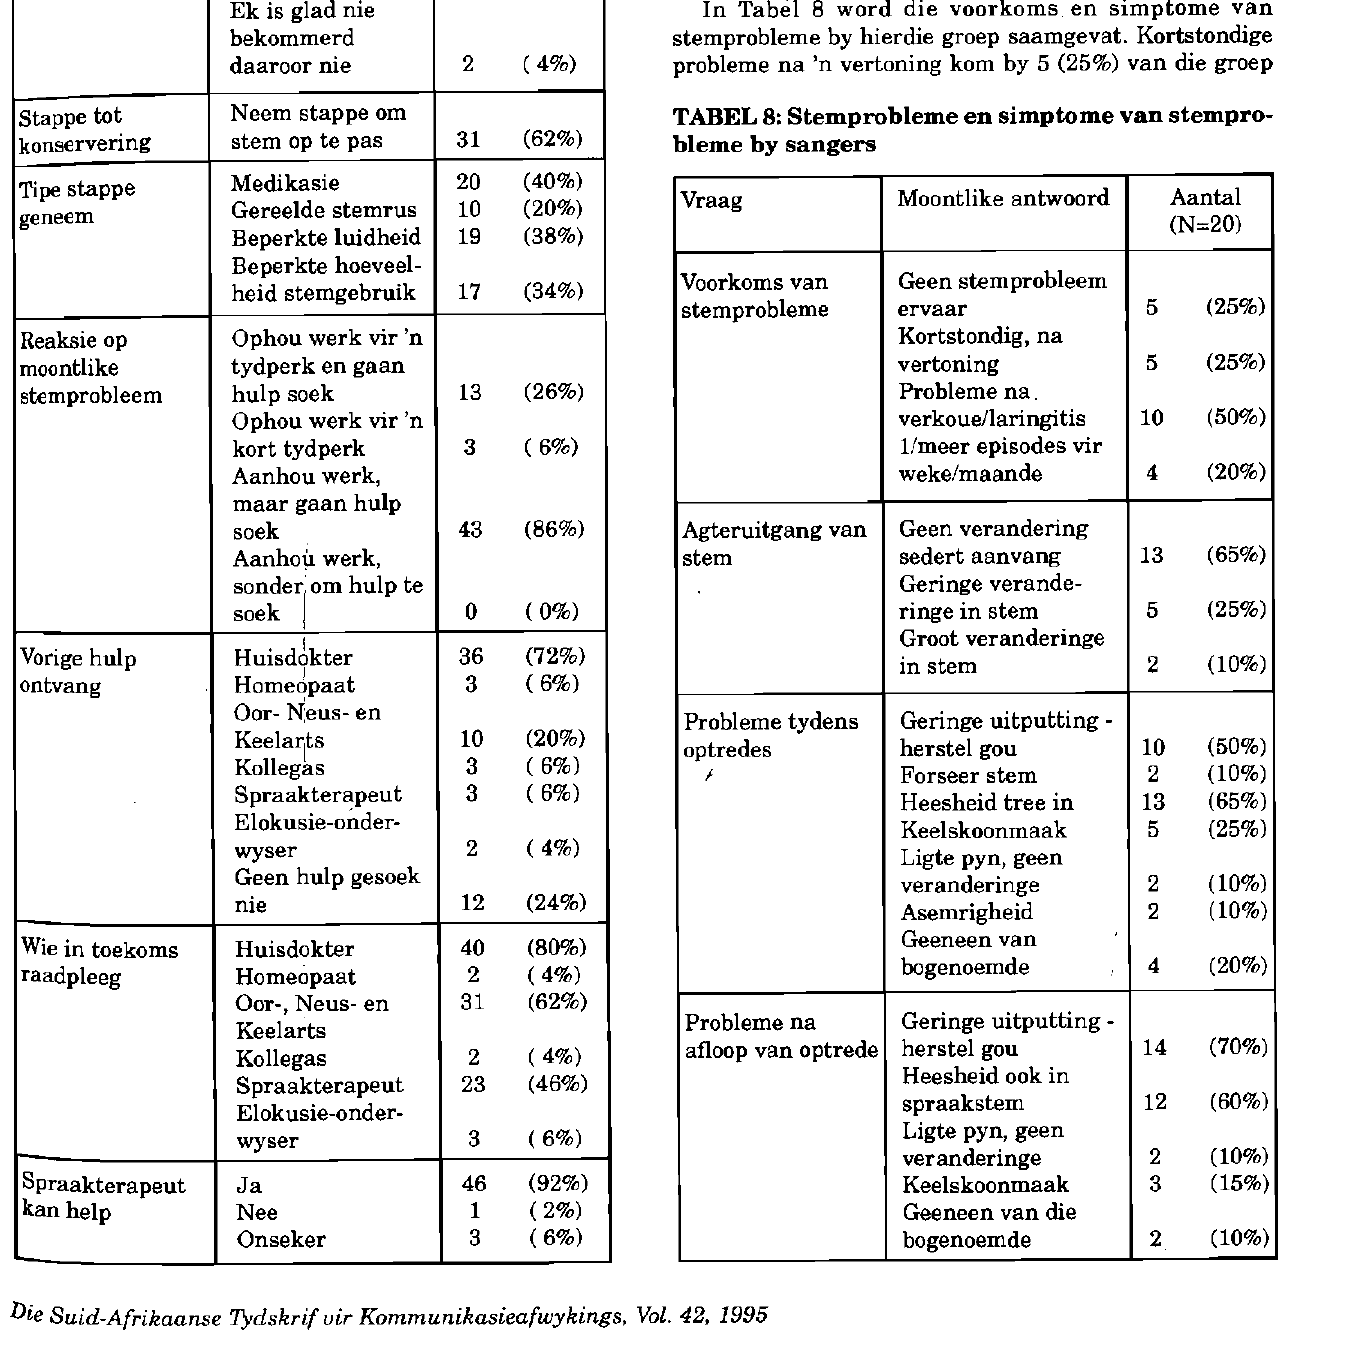
TABEL 8: Stemprobleme en simptome van